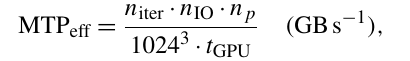
Table 2. List of the graphical processing units (GPUs) used for multi-GPU simulations. GPU Architecture On-chip memory 8 × V100 Volta 8 × 32 128 × GTX Titan X Maxwell 128 ×